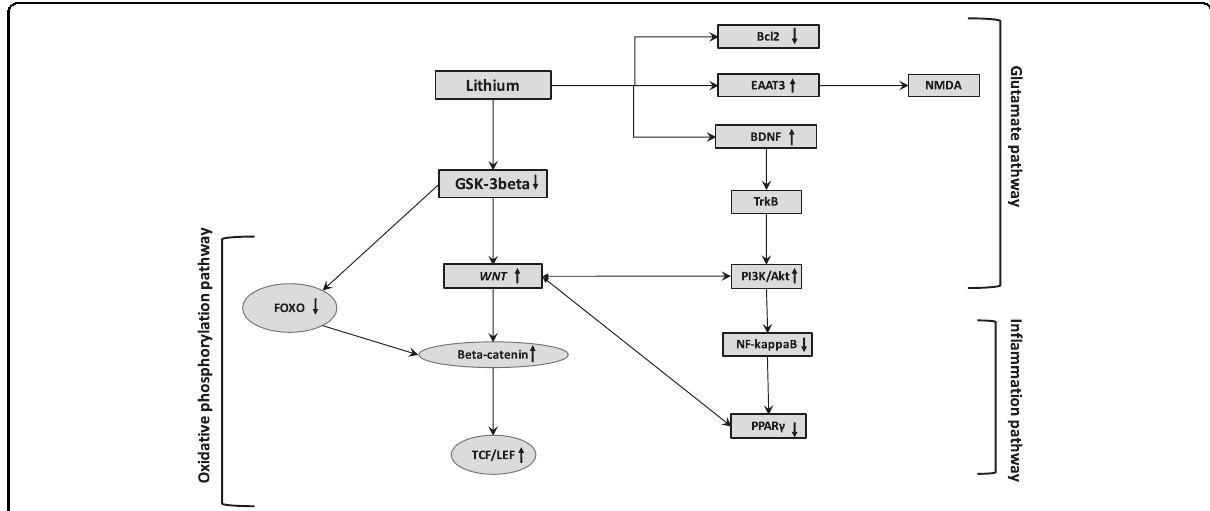
Fig. 2 Lithium interactions with oxidative stress, in fl ammation, and glutamatergic